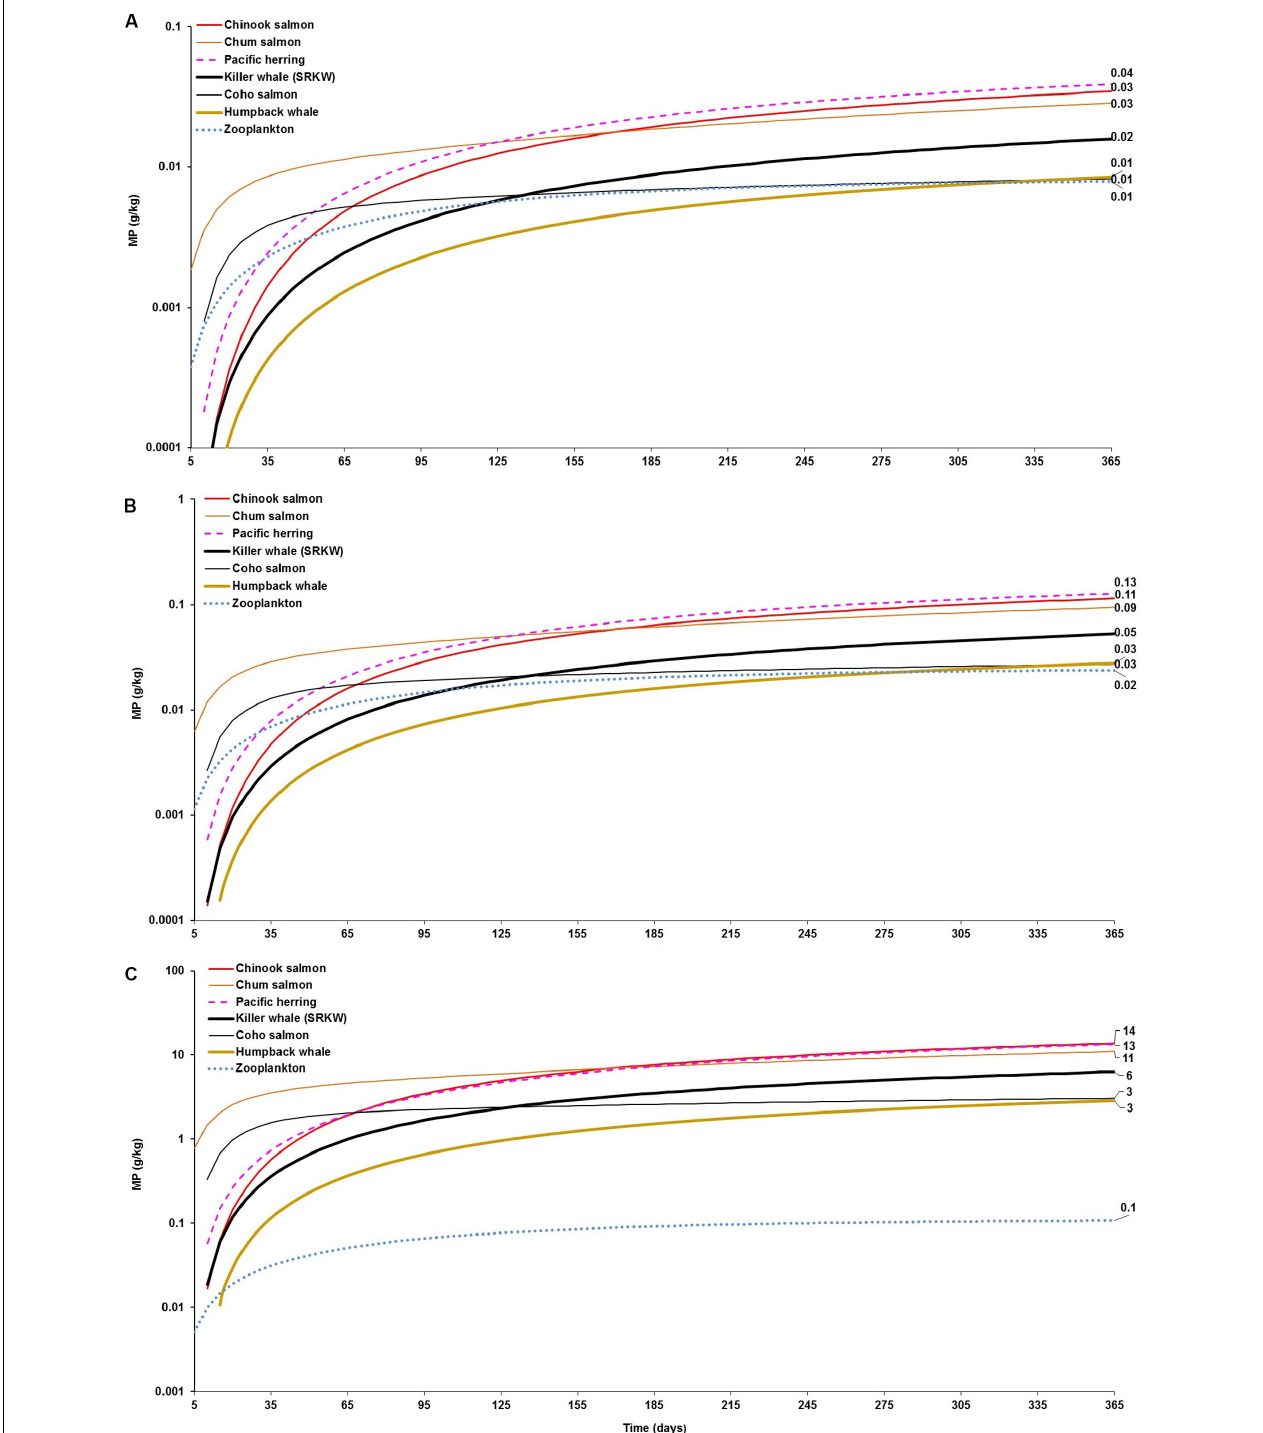
FIGURE 2 | Foodweb model simulations showing the projections of microplastics (MPs) bioaccumulation in the cetaceans’ food webs (filter feeding humpback whale and fish-eating killer whale food webs) for the three abiotic concentration scenarios: (A) low concentration (scenario 1): seawater = [0.003 g/L]; and, sediment = [0.266 g/kg dw]; (B) moderate concentration (scenario 2): seawater = [0.010 g/L]; and, sediment = [0.886 g/kg dw]; and (C) high concentration (scenario 3): seawater = [0.04 g/L]; and, sediment = [111 g/kg dw]. The simulations for the bioaccumulation include the elimination rates, and growth dilution for most organisms based on the literature reported elsewhere (see Supplementary Table S1 ). For zooplankton, as the key trophic level for the initial uptake of microplastics a k E = 0.143/d (i.e., retention time = 7 days) was used as a least conservative scenario, based on the study by Cole et al. (2013).